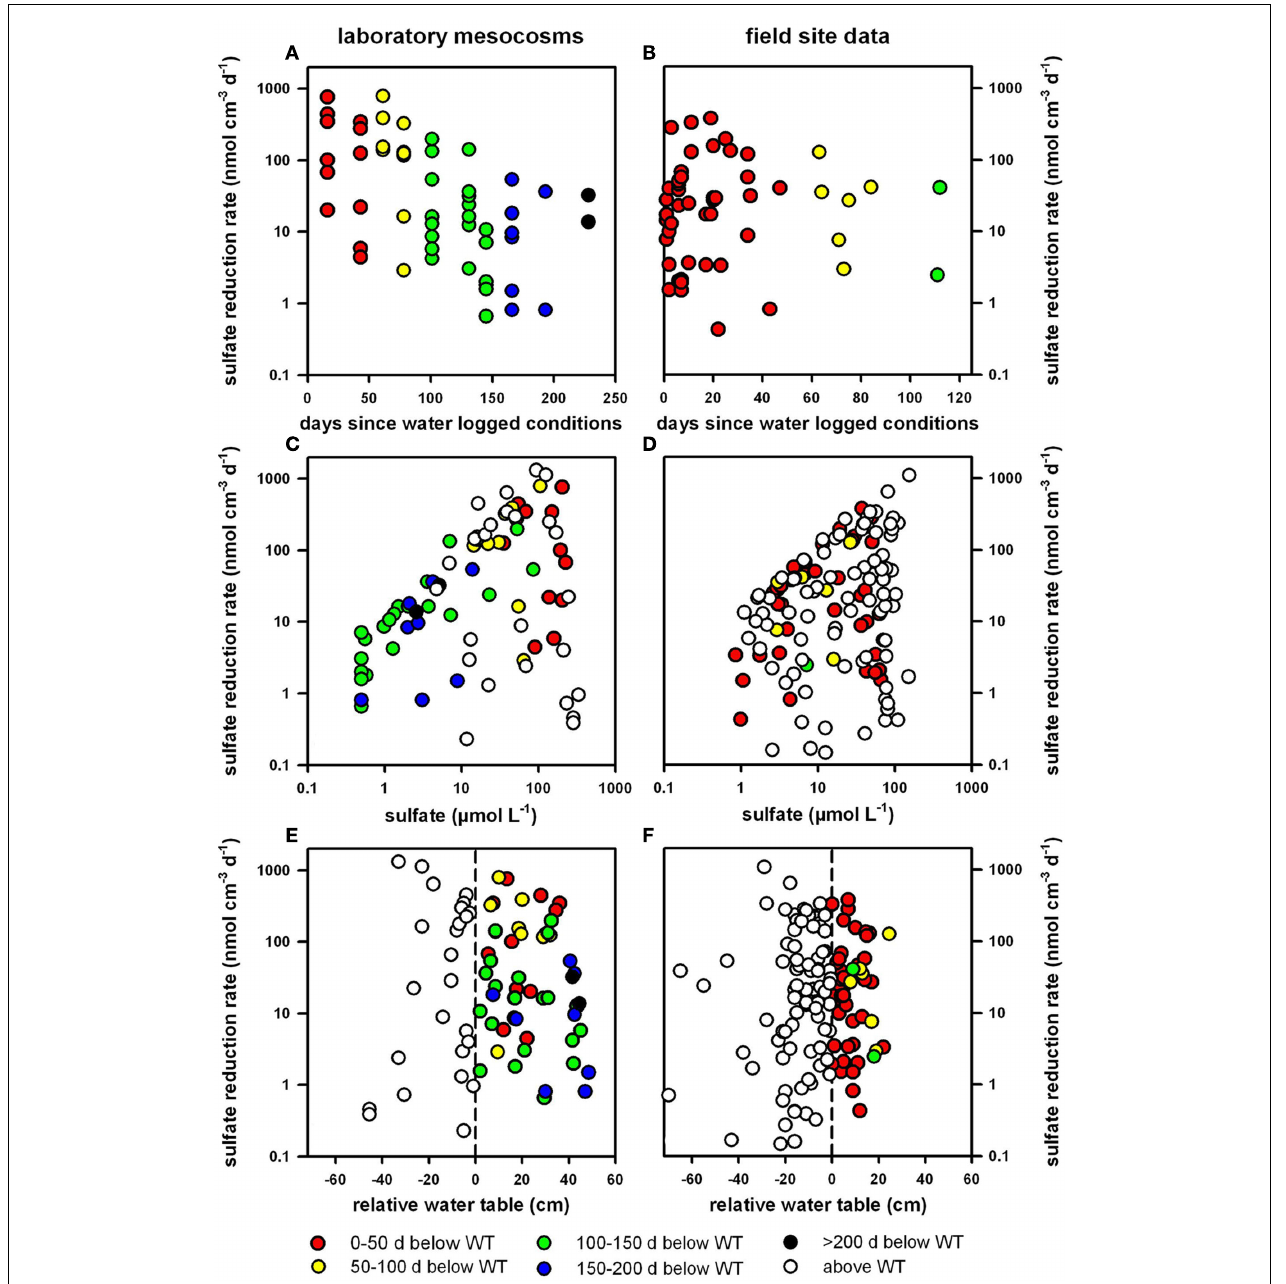
depended on prevailing sulfate concentrations (C,D) and a similar wide span in sulfate reduction rates was observed above and below the water table with the water table representing the transition zone between oxic to anoxic conditions (E,F) .Time spans in the legend represent the incubation time (days) of soils below the water table (WT). Negative and positive values on the abscissa ( x -axis) in subfigure (E) and (F) represent relative positions above and below the water table,